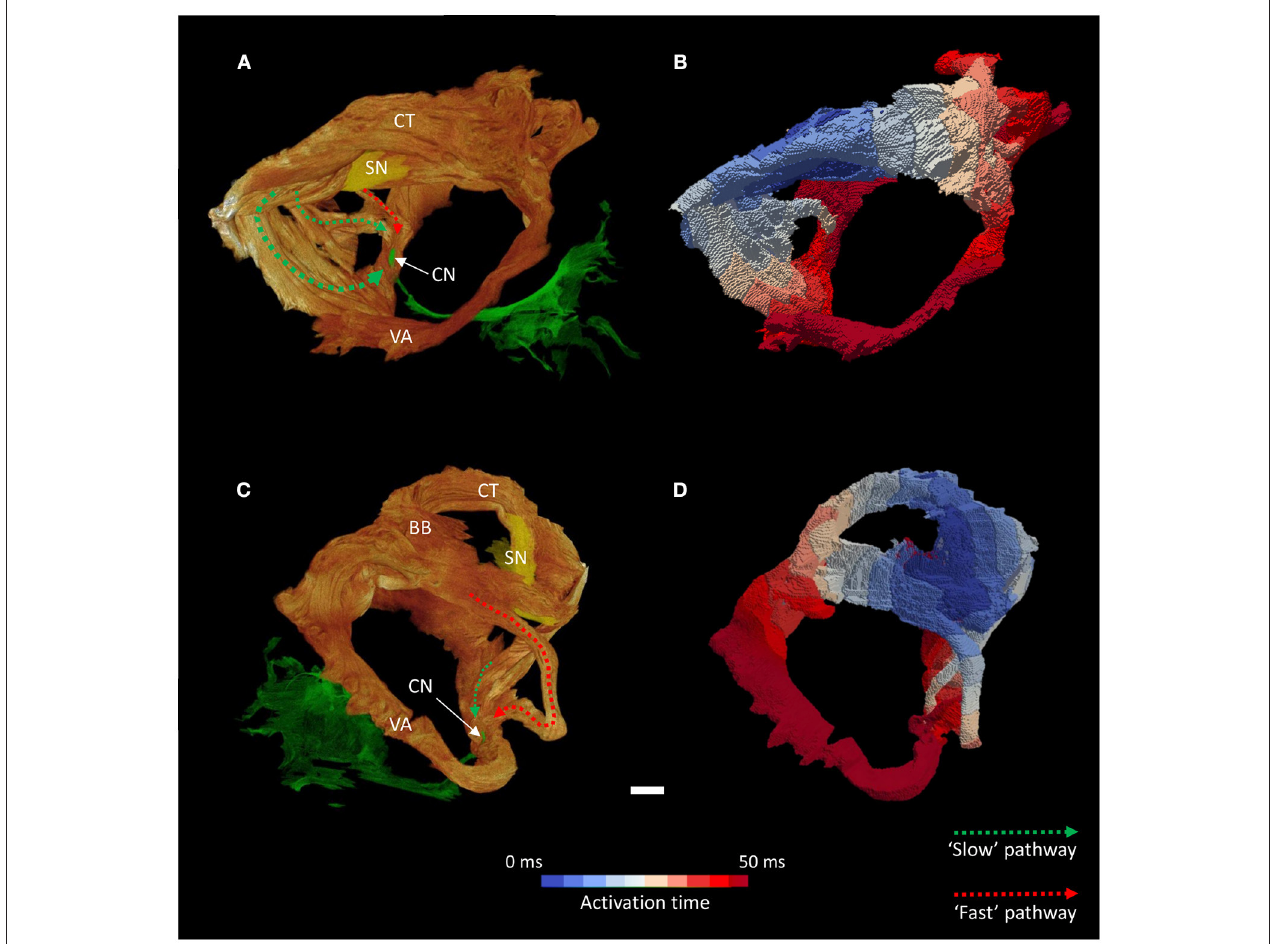
FIGURE 5 | Inter-nodal conduction through the atrial muscle bundles I. Volume renderings of the atrial muscle bundles in right lateral (A) and left lateral (C) views, the normal location and direction of the “slow” pathway (green), and the septal aspect of the elongated “fast” pathway (red) are indicated by dotted arrows. (B,D) Display the corresponding electrical activation maps, showing excitation of the distal aspect of the region normally associated with the “slow” pathway precedes that of the “fast” pathway. See methods for modeling parameters. BB, Bachmann’s bundle; CN, compact atrioventricular node; CT, terminal crest; SN, sinus node; VA, valve annulus. Scale bar represents